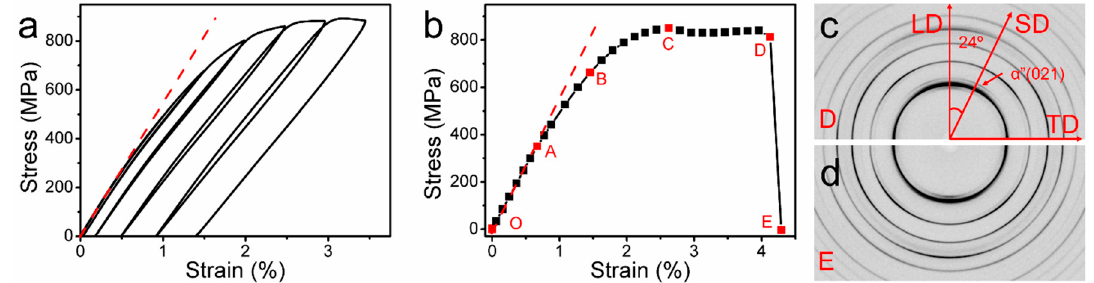
Figure 3. Mechanical behavior and SXRD patterns of the Ti36Nb5Zr alloy during tensile loading. ( a ) Cyclic stress–strain curves with 0.5% strain step. ( b ) Uniaxial tensile stress–strain curve during in situ SXRD experiment. The 2D SXRD patterns at different applied strains as noted in ( b ): ( c ) 4.13% (point D), ( d ) after fracture (point E). LD, TD and SD in ( c , d ) are abbreviations of loading direction, transverse direction and specific direction, respectively.